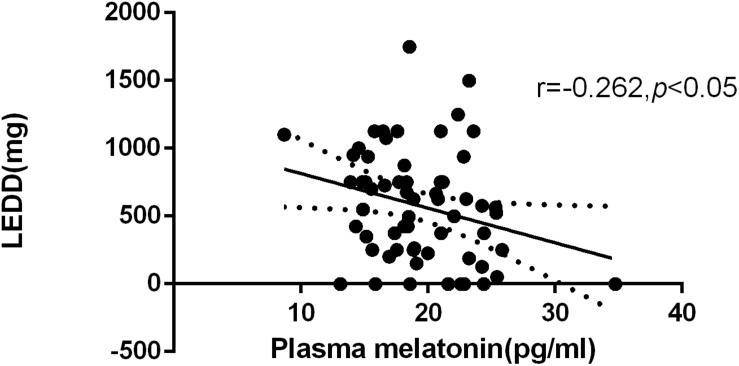
Relationship between plasma melatonin concentrations and levodopa equivalent daily dose. Plasma melatonin levels were negatively correlated with levodopa equivalent daily dose (Pearson’s correlation coefficient r = –0.262, P < 0.05, n = 61).